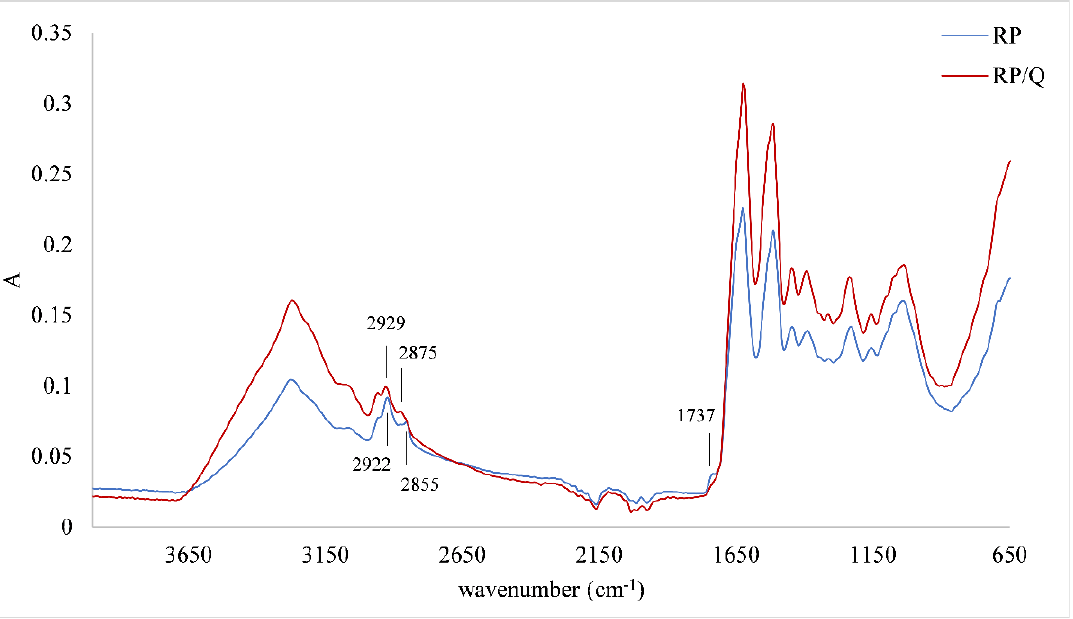
Figure 2. IR spectra of brown rice protein matrix (R) and brown rice protein/quercetin microparticles (RP/Q).